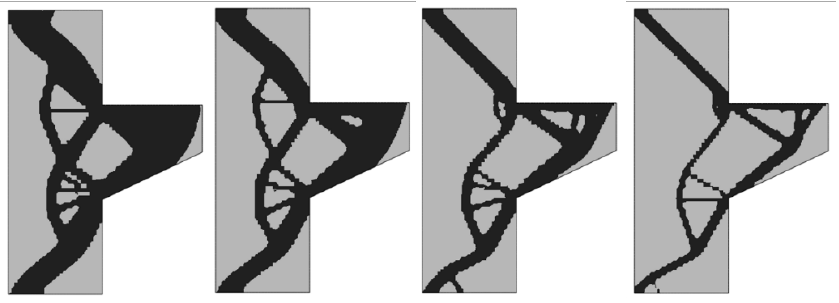
Figure 15. Optimized distribution of material for mesh b), volume fractions of 50%, 40%, 30% and 20%,